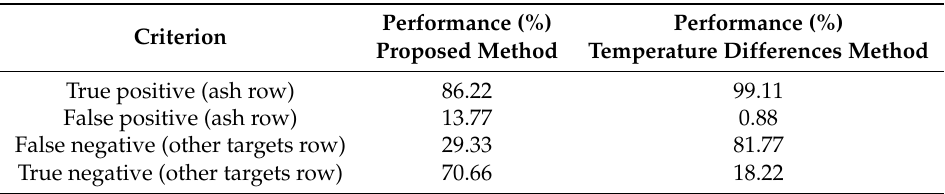
Figure 6. Validation of spectral retrieval with a synthetic image. ( a ) Synthetic image constructed using (i) ash cloud pixels at high density (Ash H), (ii) ash cloud pixels at medium density (Ash M), (iii) ash cloud pixels at low density (Ash L), (iv) pixels from the ocean target, (v) pixels from land target, and (vi) pixels from water cloud target. ( b ) Recovered spectra with the proposed method (in µ W/cm 2 nm) using VIS channel responses from the synthetic image. Table 2. Comparison between both the proposed and temperature difference methods, using binary classification (in percentage